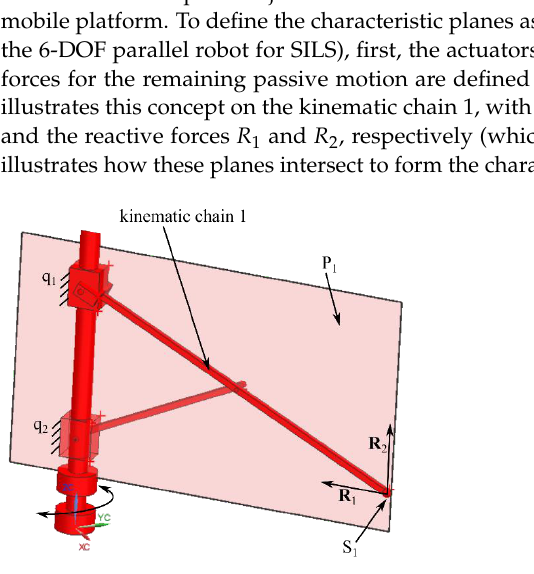
Figure 5. Characteristic plane defined for the kinematic chain 1.